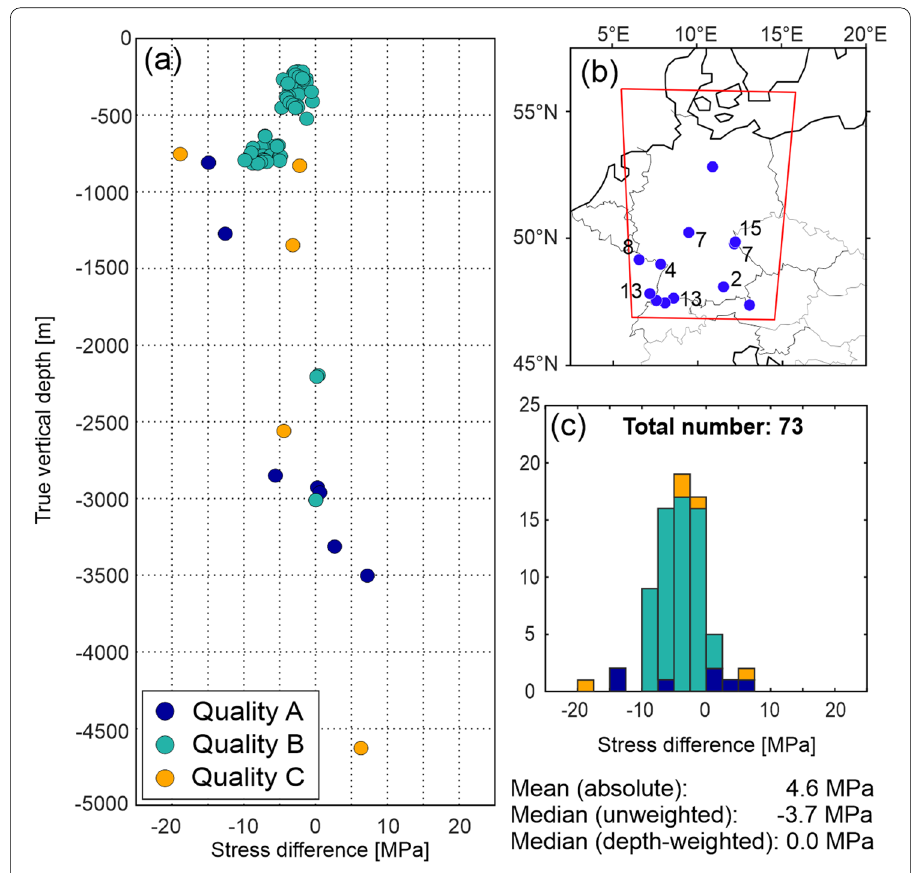
Fig. 6 S hmin magnitudes of the model in comparison to data of Morawietz and Reiter (2020) used for calibration. a Color‑coded differences versus depth. Differences are calculated as model results minus calibration data. b Spatial distribution of stress magnitude data, used for calibration. Numbers indicate localities with multiple data records. c Color‑coded histogram of the differences displayed in